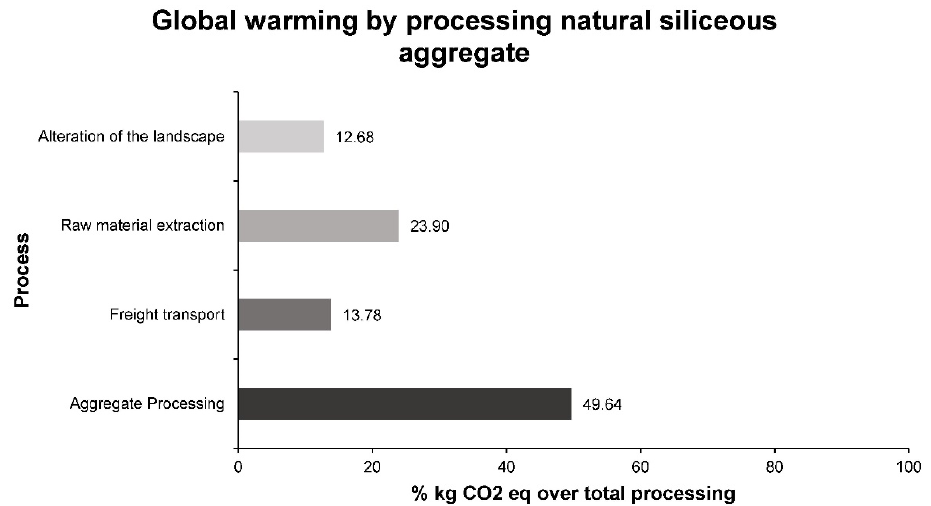
Figure 4. Percentages of kg of CO 2 per stage in the process of obtaining natural silica aggregates for use in bituminous mixtures.